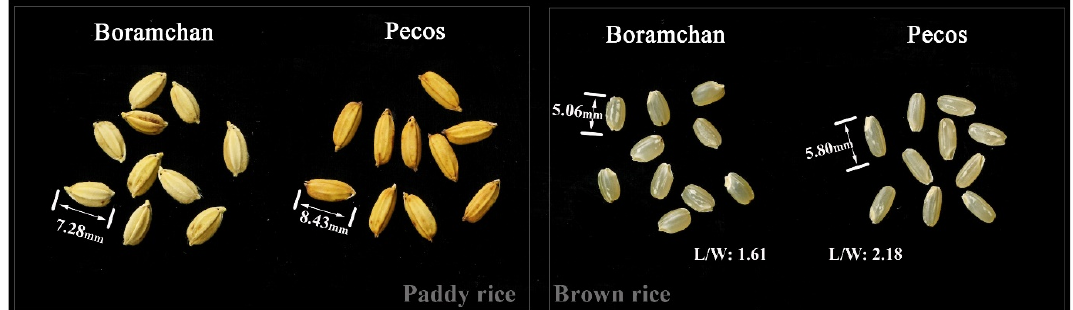
Figure 6. Grain shape of the parents, Boramchan and Pecos, were used in this study. L/W—ratio of length to width.